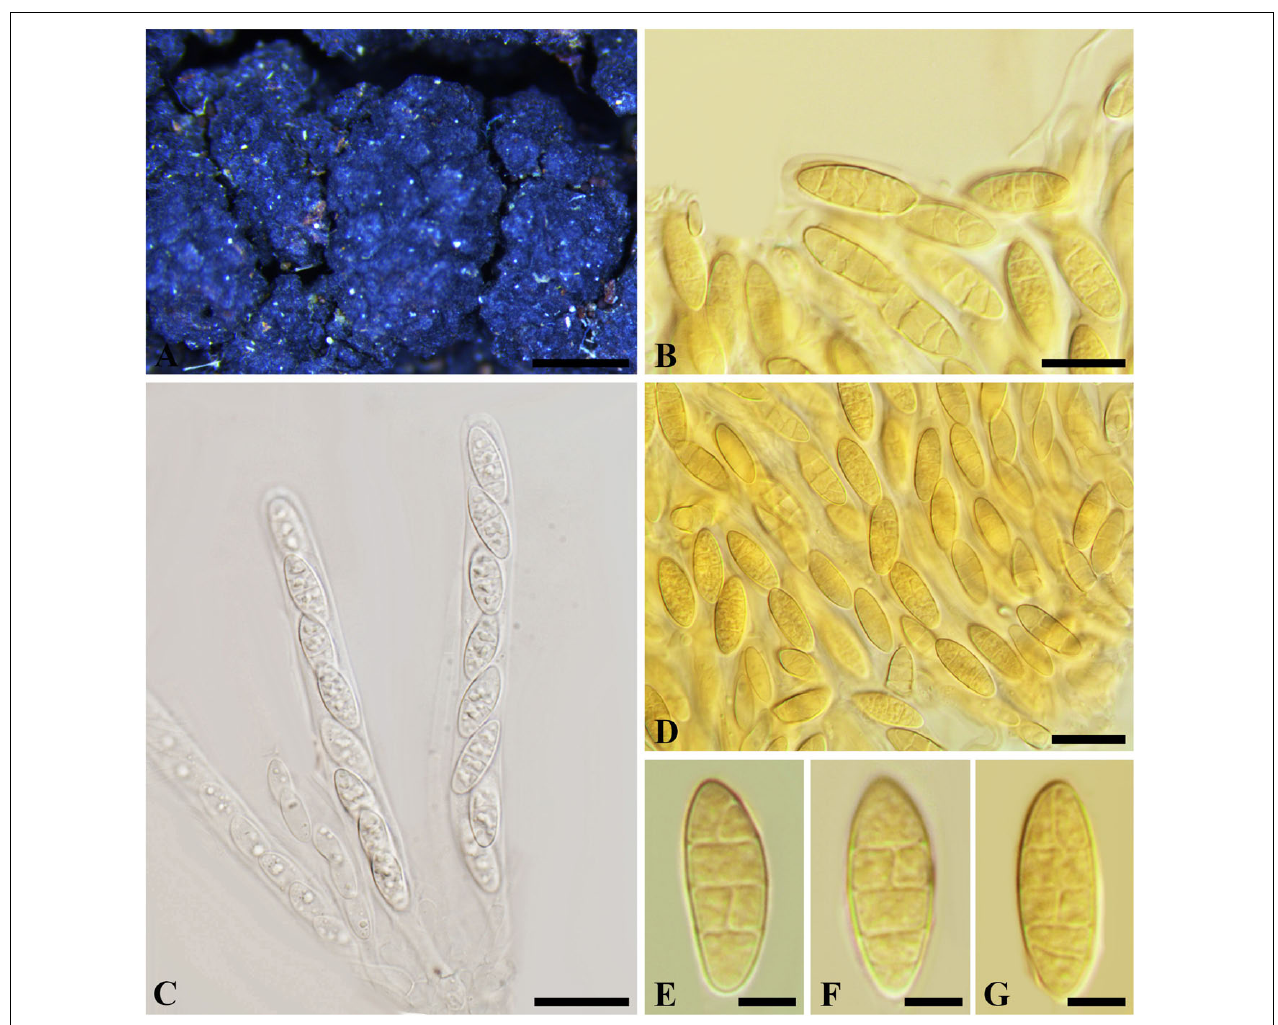
FIGURE 11 | Nothophoma ferruginea (G 00127285, holotype ). (A) Densely gregarious ascomata. (B,D-G) Ascospores in Melzer’s reagent. (C) Ascus with ascospores in water. Scale bars: (A) = 1 mm, (B) = 10 µ m, (C,D) = 20 µ m, (E-G) = 5 µ